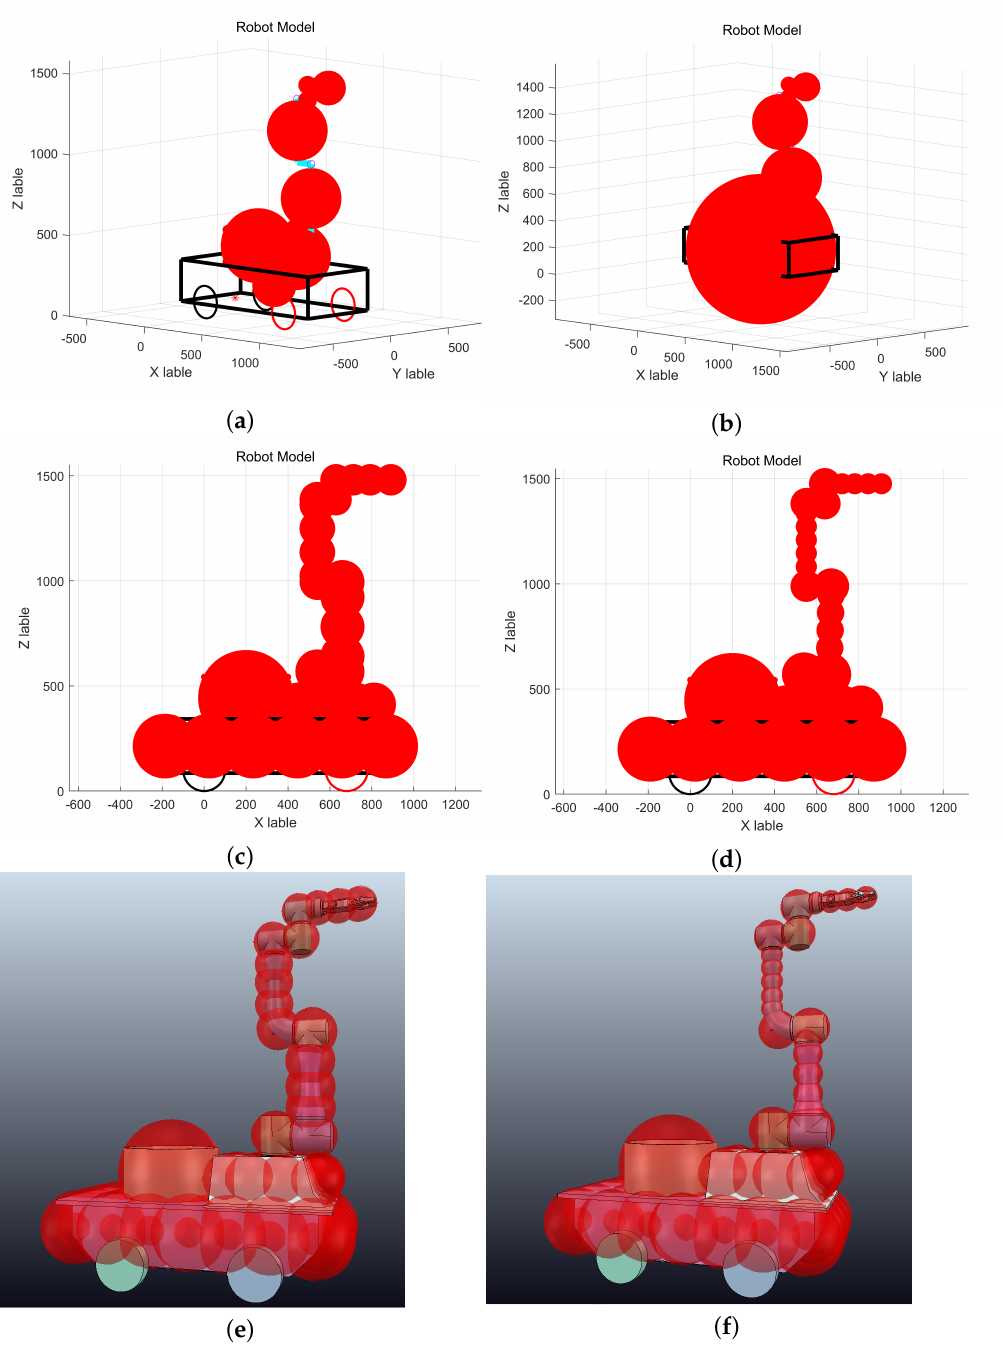
Figure 7. Approximating the mobile manipulator robot by a single spherical object. ( a ) The ap- proximation described by the single small spherical object; ( b ) The approximation described by the single large spherical object; ( c ) The approximation described by the method proposed in article [36]; ( d ) The approximation described by the method proposed in this study; ( e ) The approximation result of the mobile manipulator robot using the method proposed in article [36]; ( f ) The approximation result of the mobile manipulator robot using the method proposed in this